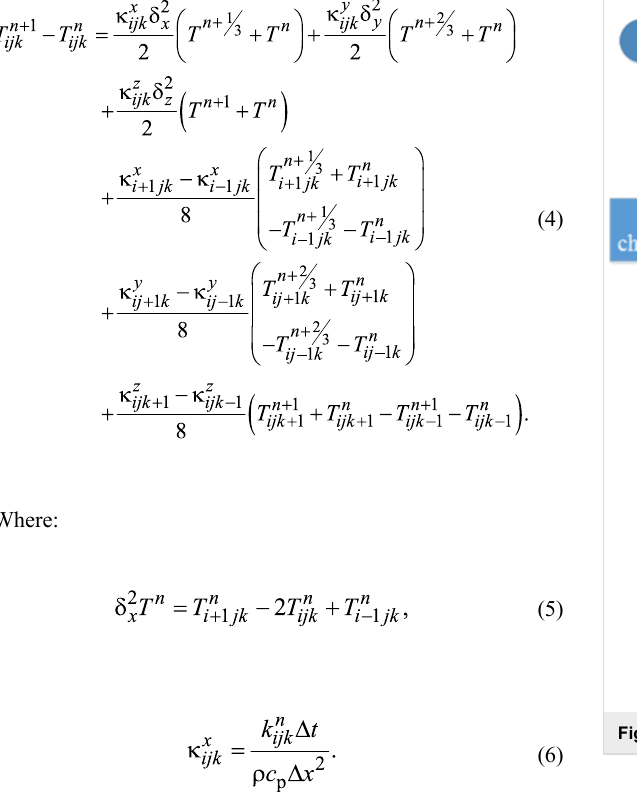
Figure 9: The computational flowchart at each time